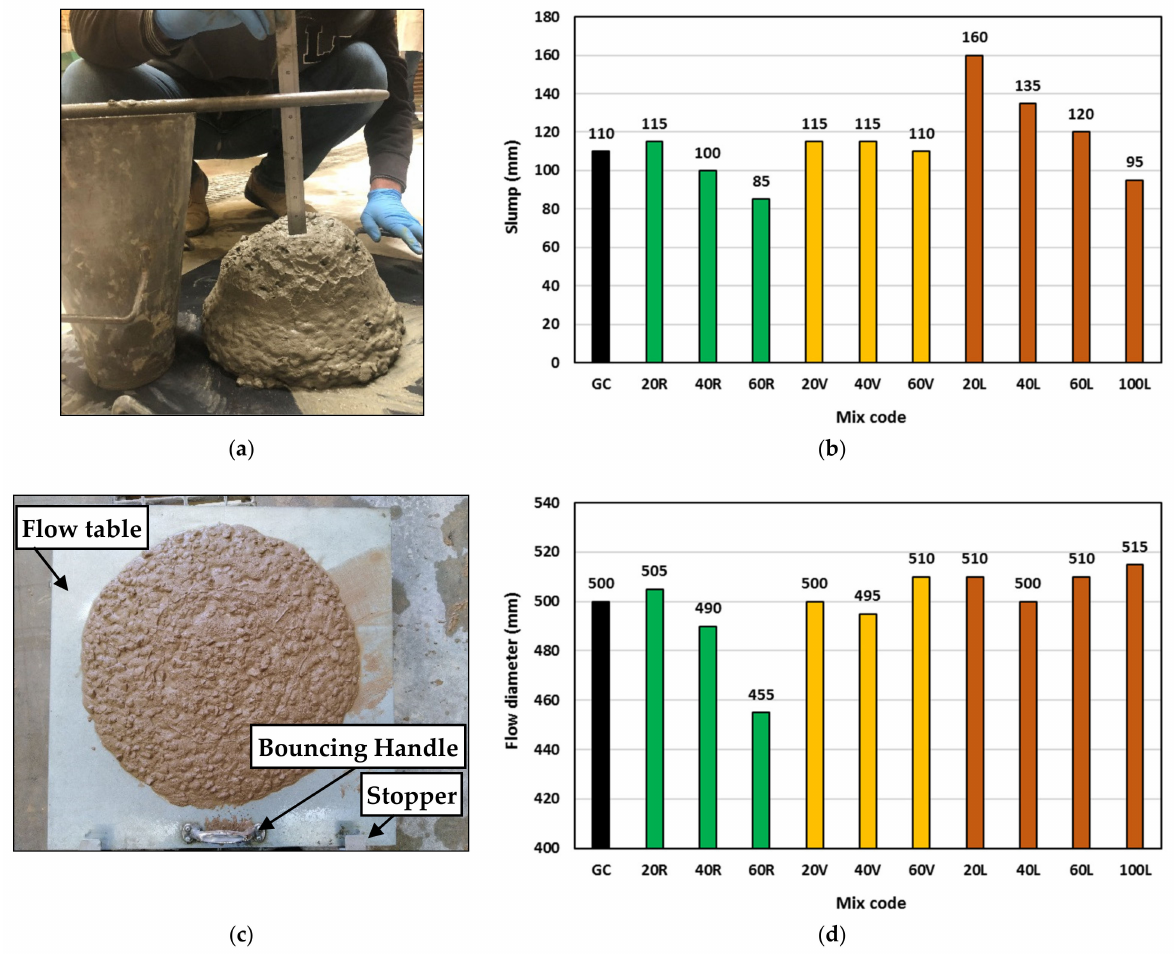
Figure 6. Concrete workability: ( a ) slump measurement, ( b ) slump values, ( c ) flow diameter mea- surement, and ( d ) flow diameter